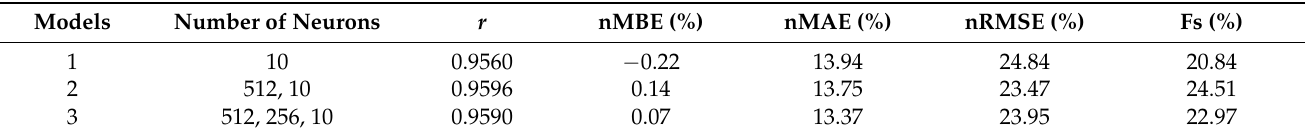
Table 3. The performance of the SCNN-LSTM model with different AlexNet improvement structures. Models